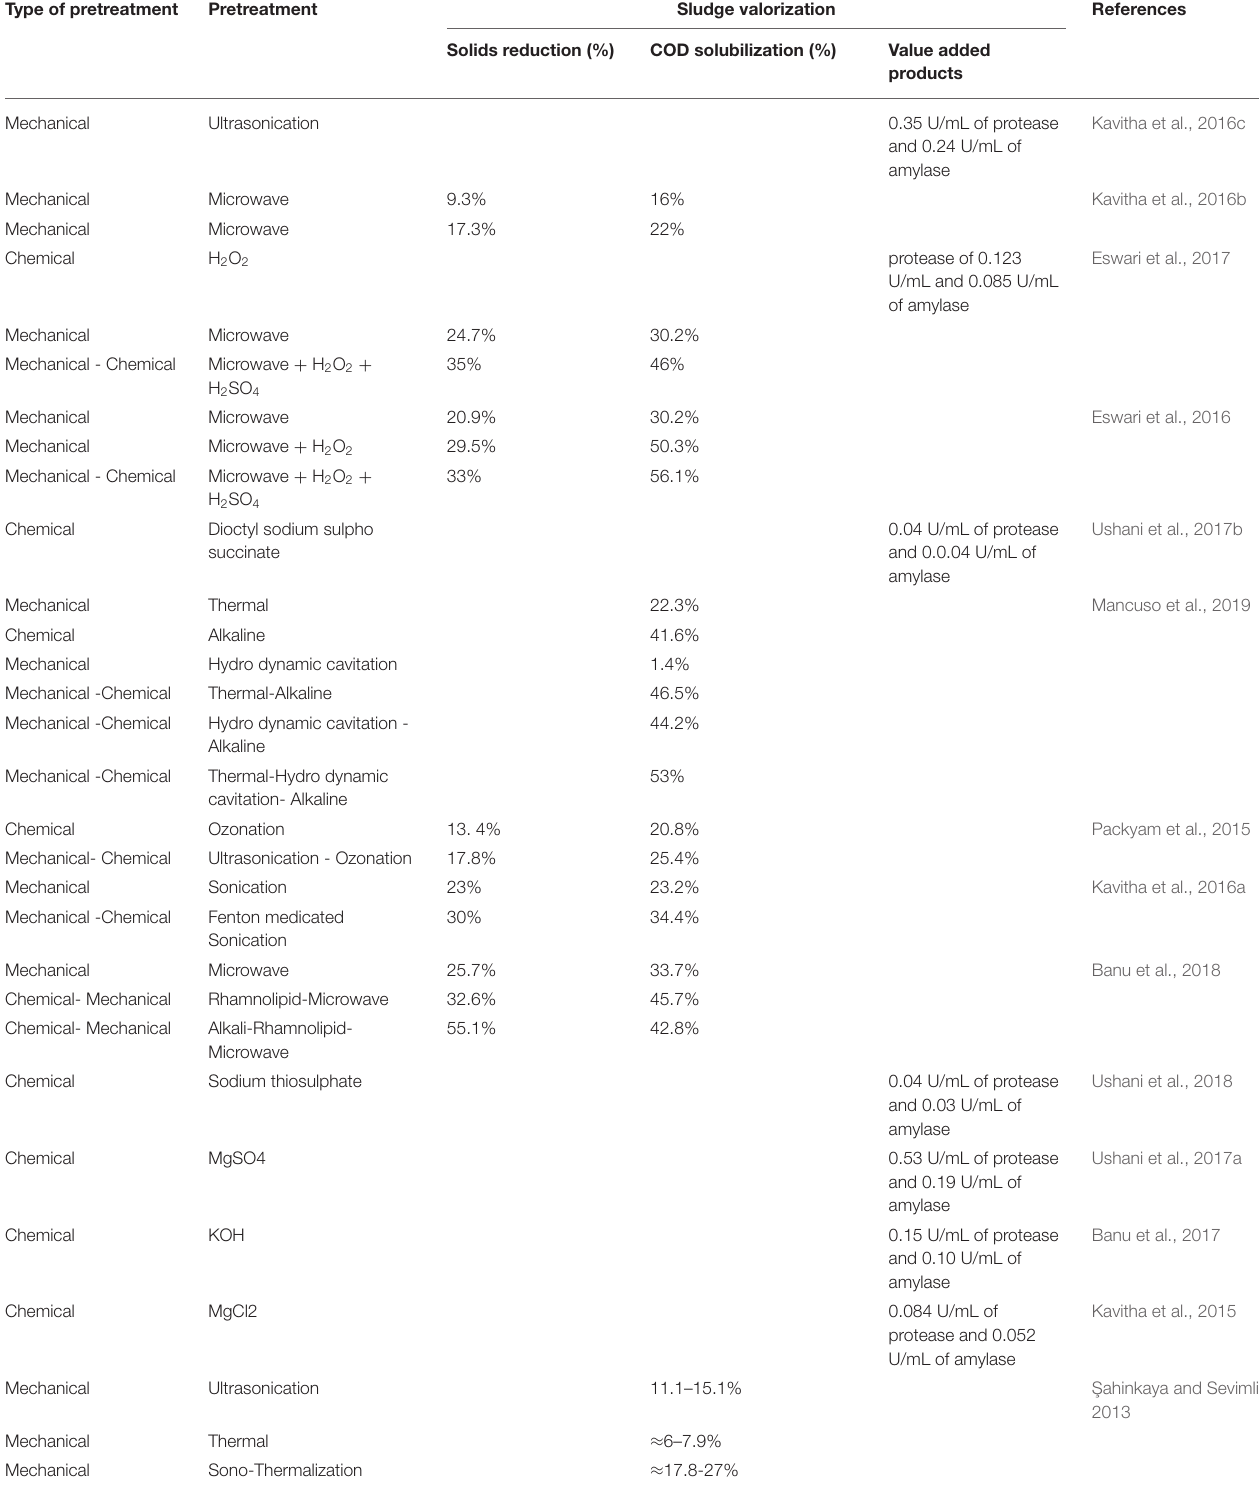
TABLE 1 | Summary of key information of sludge pretreatment prior to biological